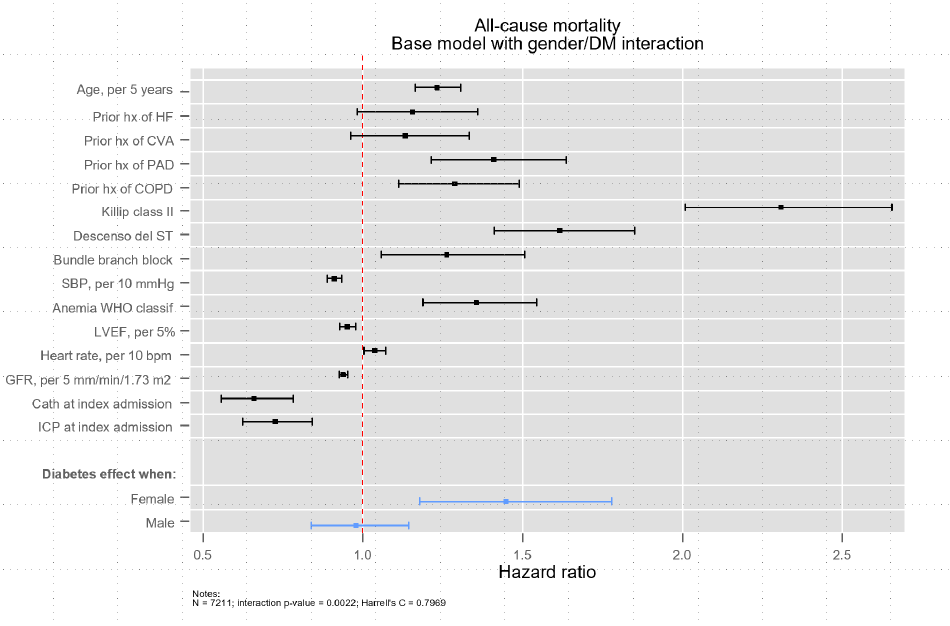
Figure 2. Independent predictors of all-cause mortality. On the other hand, age, prior stroke, peripheral artery disease, admission Killip class ≥ II, ST-segment deviation, left ventricular ejection fraction, admission systolic